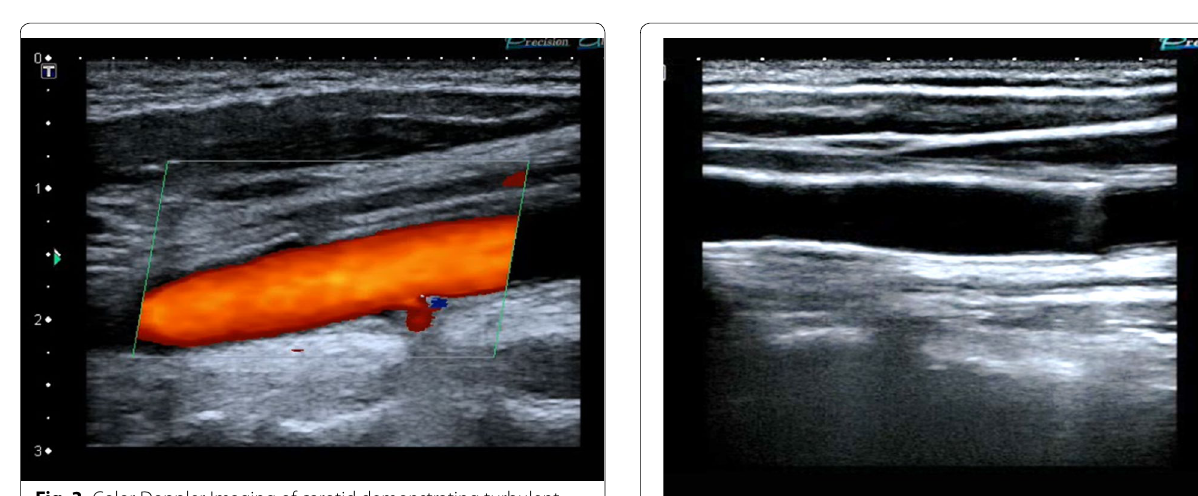
Fig. 5 Ultrasound of carotid after stenting: Longitudinal view